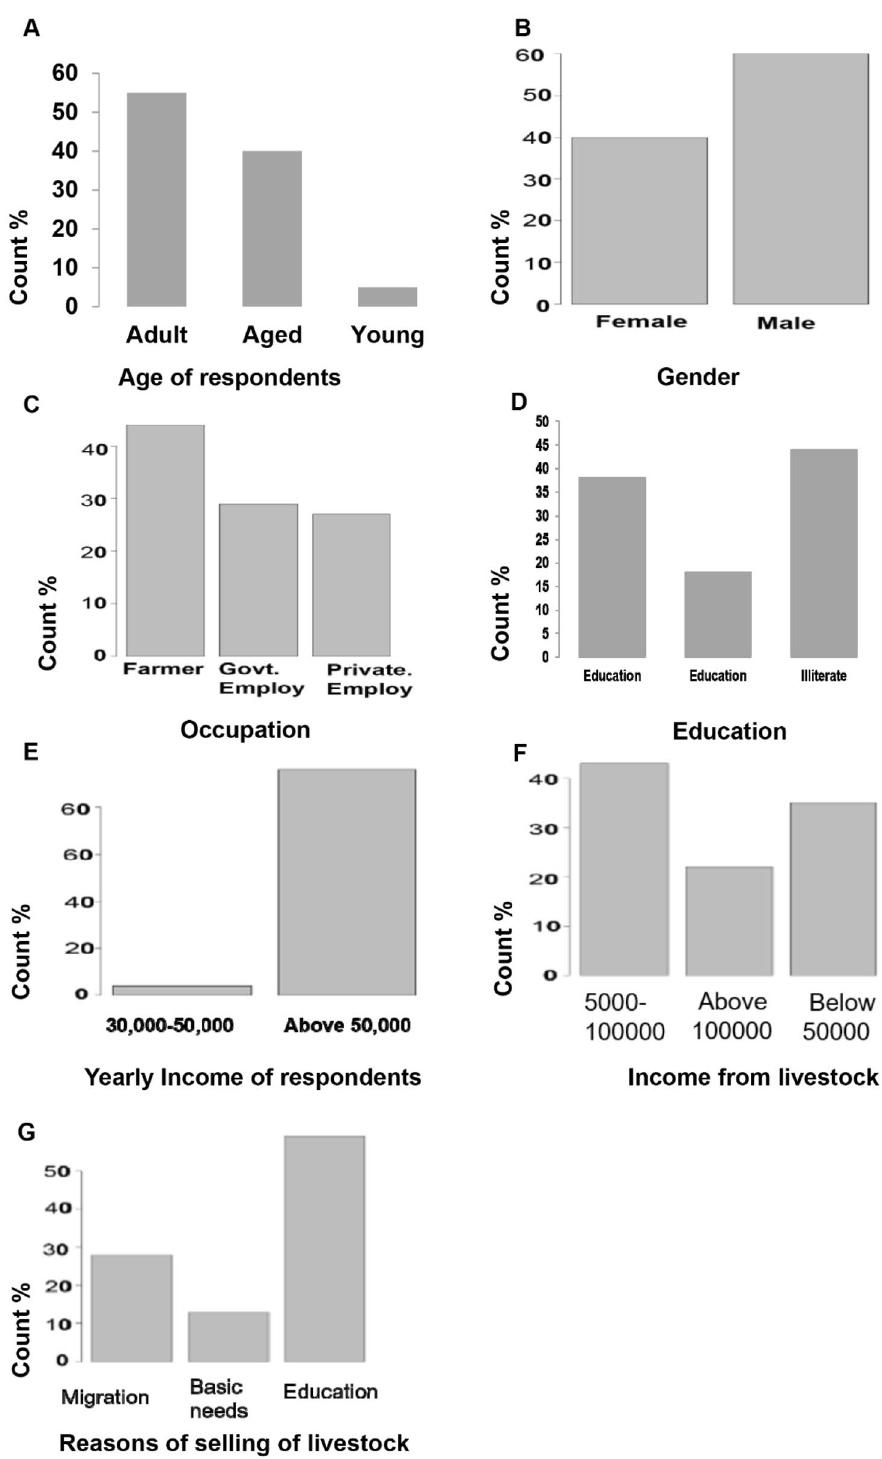
Figure 3. Socioecological profile of the of community residing at Misger